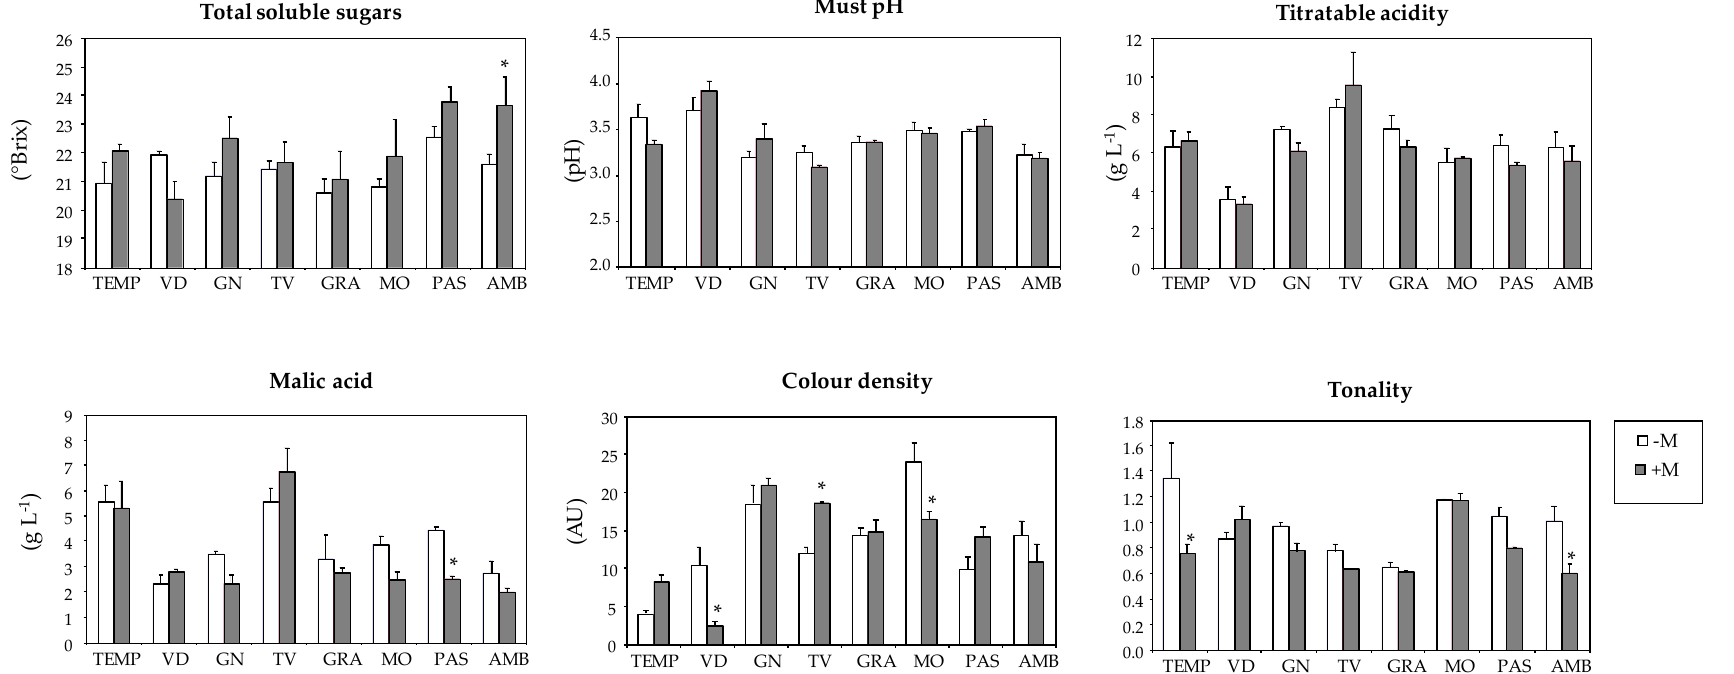
Figure 6. Must characteristics from fruit-bearing cuttings of ancient grapevine varieties inoculated with arbuscular mycorrhizal fungi (+M) or non-inoculated (-M). Values are means ± S.E. (n = 3-4). Within each variety, asterisks (*) indicate significant differences ( p ≤ 0.05) between +M and –M plants according to Duncan’s test. The variety labels can be found in Table 1. AU means absorbance units.